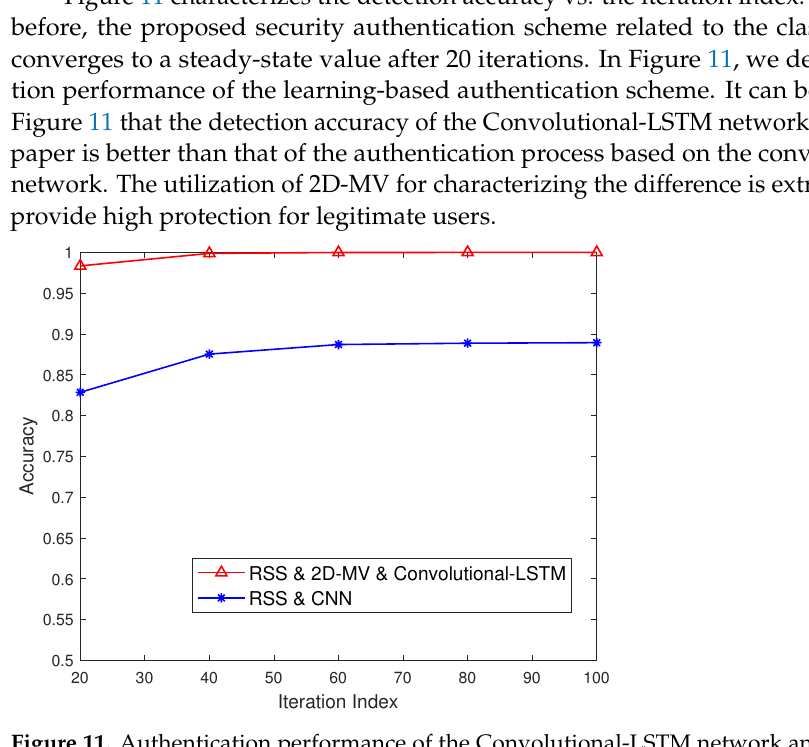
Figure 11. Authentication performance of the Convolutional-LSTM network and the CNN-based approach of [20].